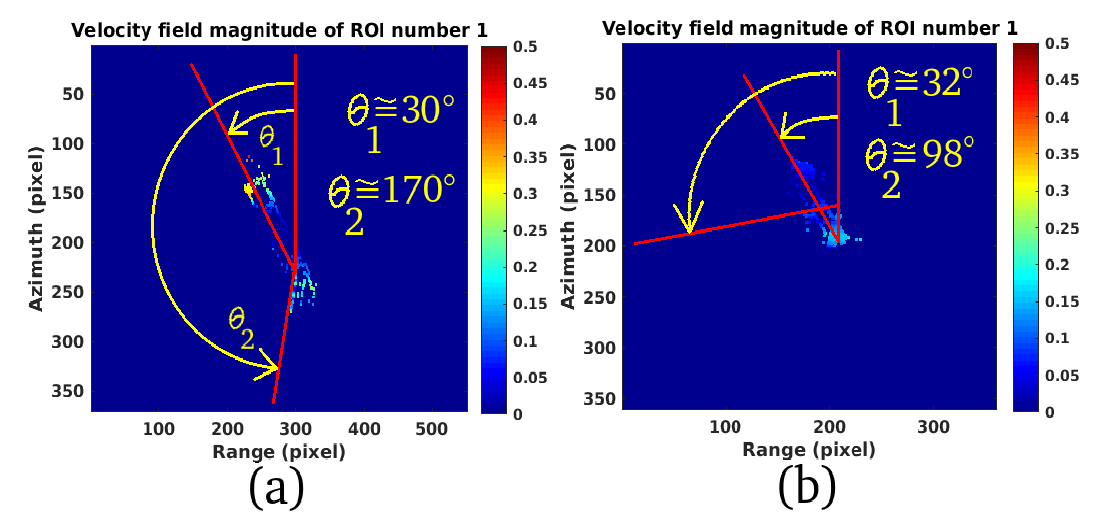
Figure 23. ( a ): Study case number 1 target angles estimation. ( b ):Study case number 2 target angles